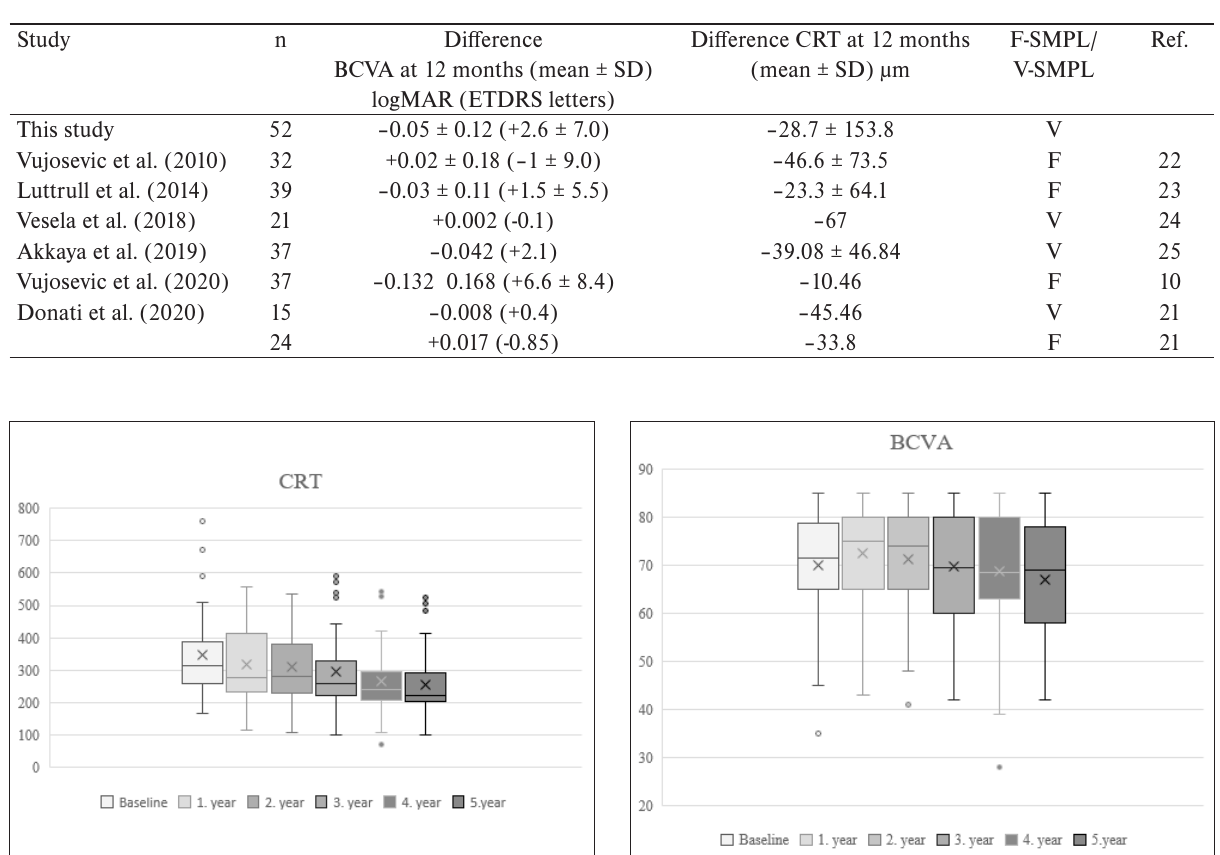
Table 3. Our results of DME treatment with SMPL compared with the alredy published studies in the monitoring period 12 months.